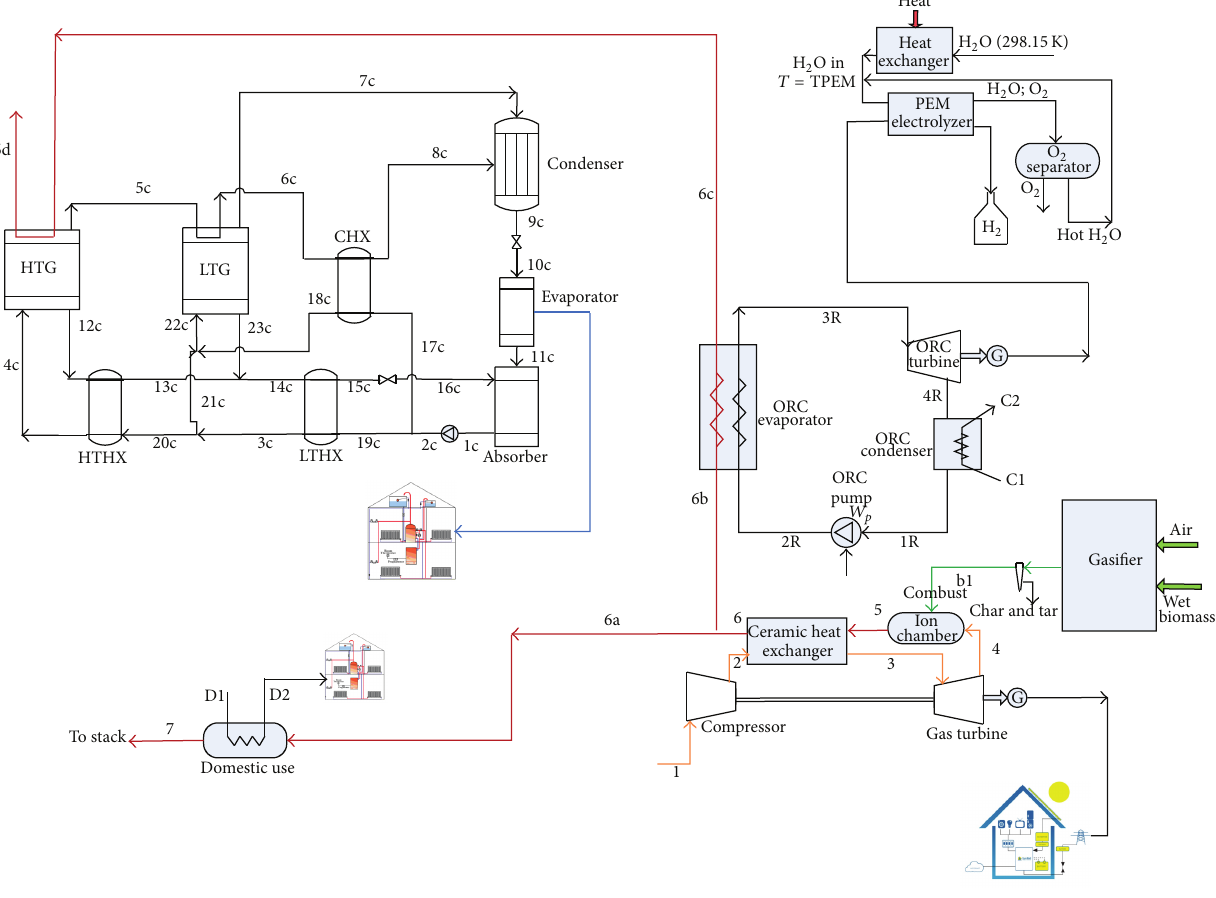
Figure 1: Schematic diagram of multigeneration